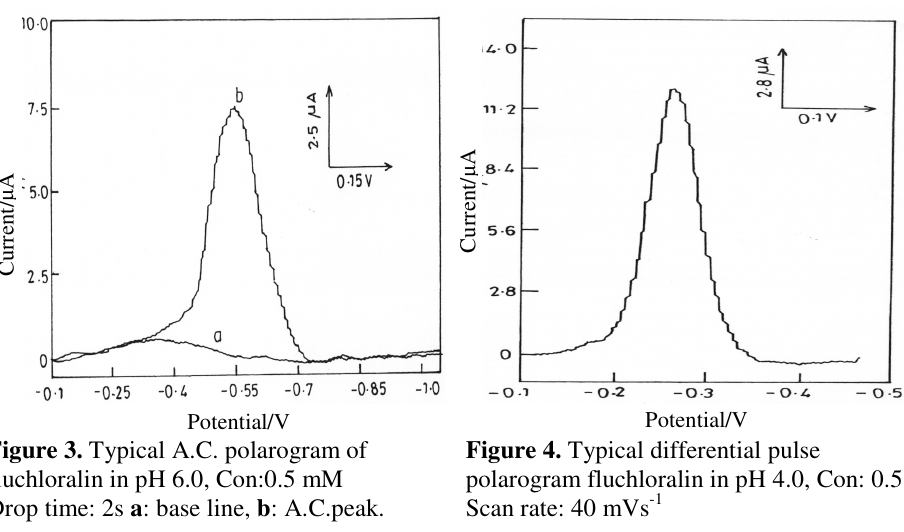
Figure 3. Typical A.C. polarogram of fluchloralin in pH 6.0, Con:0.5 mM Drop time: 2s a : base line, b : A.C.peak.